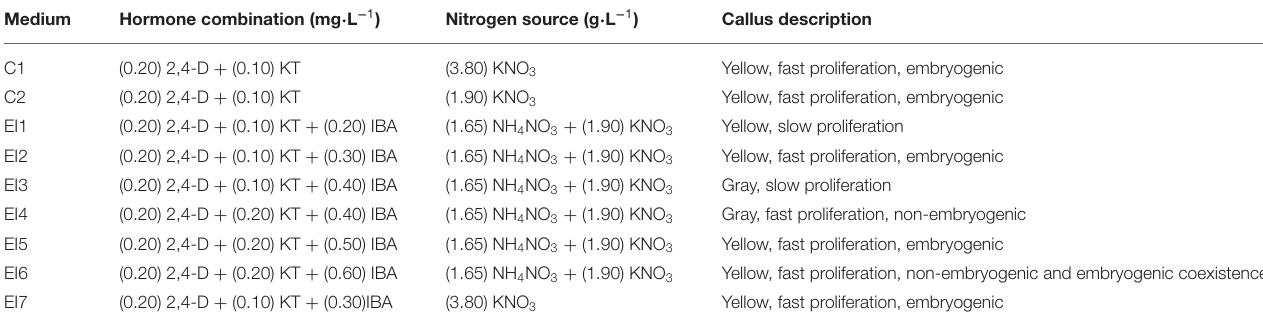
TABLE 1 | Effects of PGR combinations on embryonic callus induction of G. sturtianum . Medium